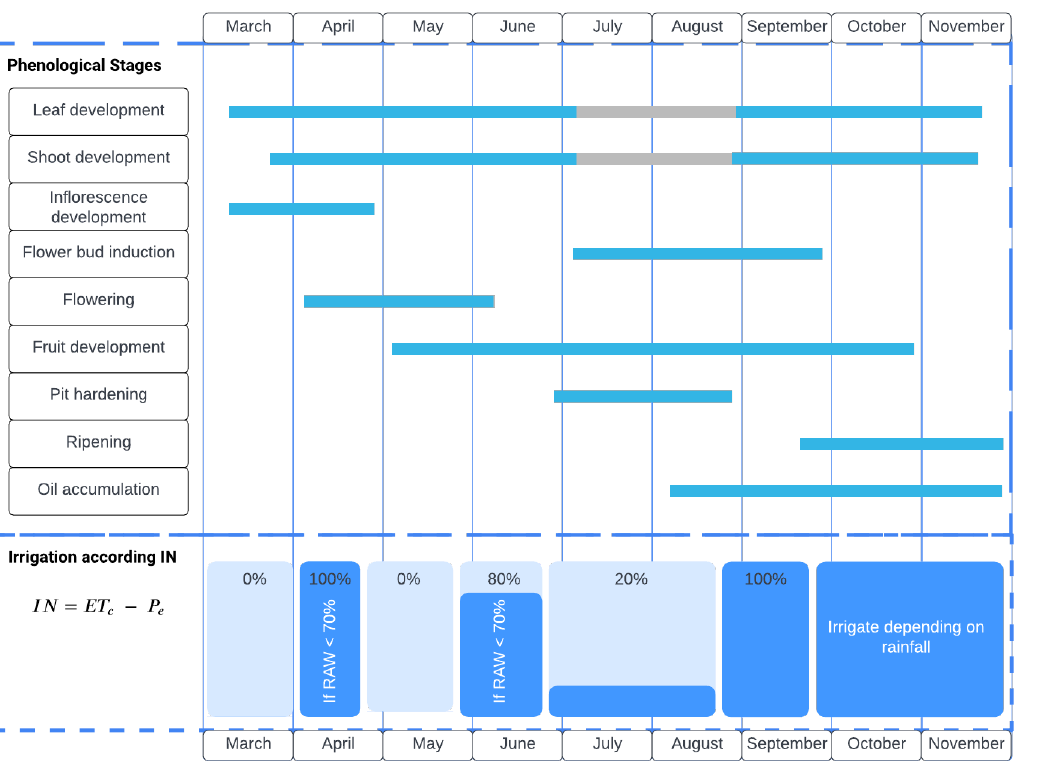
Figure 10. RDI strategy applied in a high-density olive grove to supply 60% of the crop’s water needs [40]. Modified from [41].